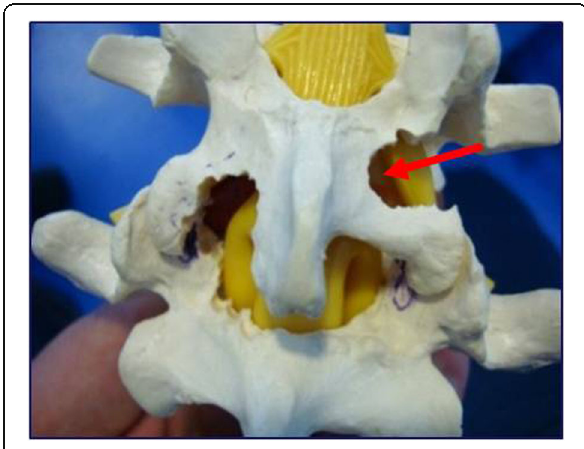
Fig. 1 Comparison between the bony work in regular fenestration and in the described approach (red